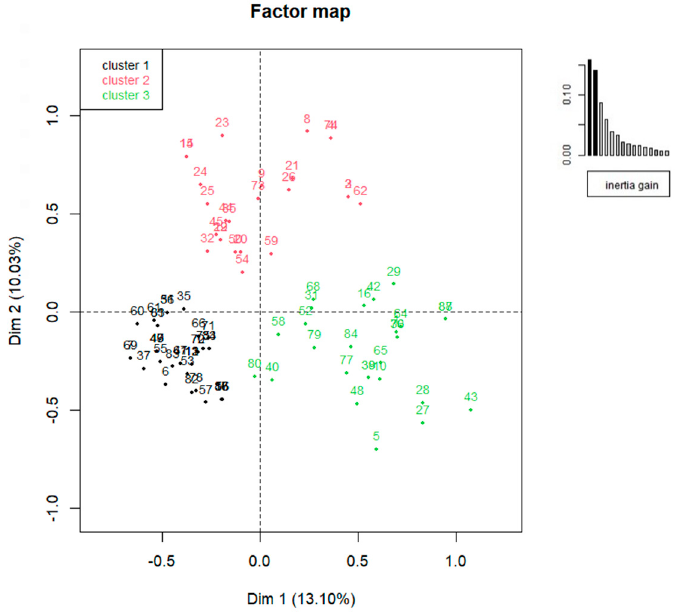
Figure 5. Cluster analysis of mechanisms reviewed in the literature (points represent mechanisms, and inertia gain shows how much variance will be obtained by adding more clusters).